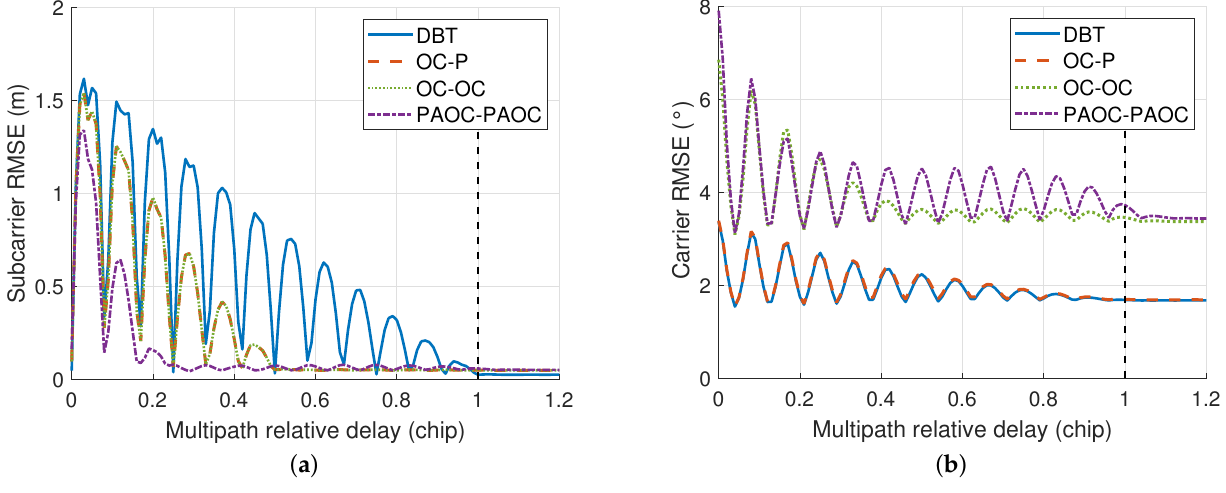
Figure 10. RMSE envelop of various methods for the BOC(15, 2.5) signal, where the multipath relative phase is 0 and π : ( a ) subcarrier RMSE; ( b ) carrier